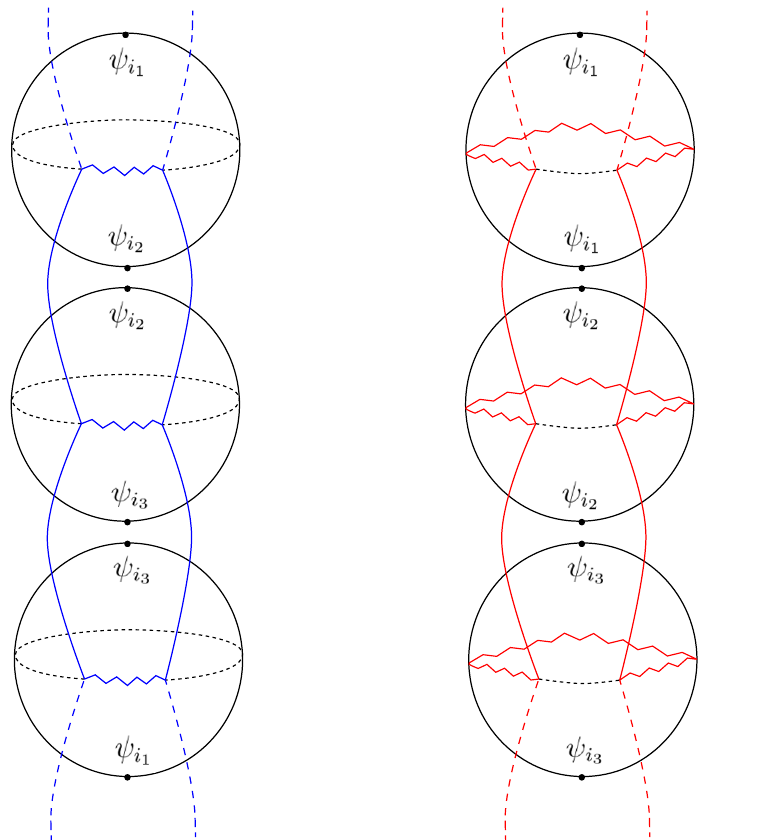
Figure 2 . Left: the replica manifold M conn for n = 3 , with operator insertions which differ on the same sheet. The blue wiggly line is the cut C x with length 2 πx , and the spheres are glued cyclically along it. Right: the replica manifold M conn , with operator insertions that are the same on a given sheet. The spheres are again glued cyclically, this time along the red wiggly line C x , which is a cut of length 2 π (1 − x ) . The path integrals on these two manifolds with the specified operator insertions are equivalent, as proven in appendix